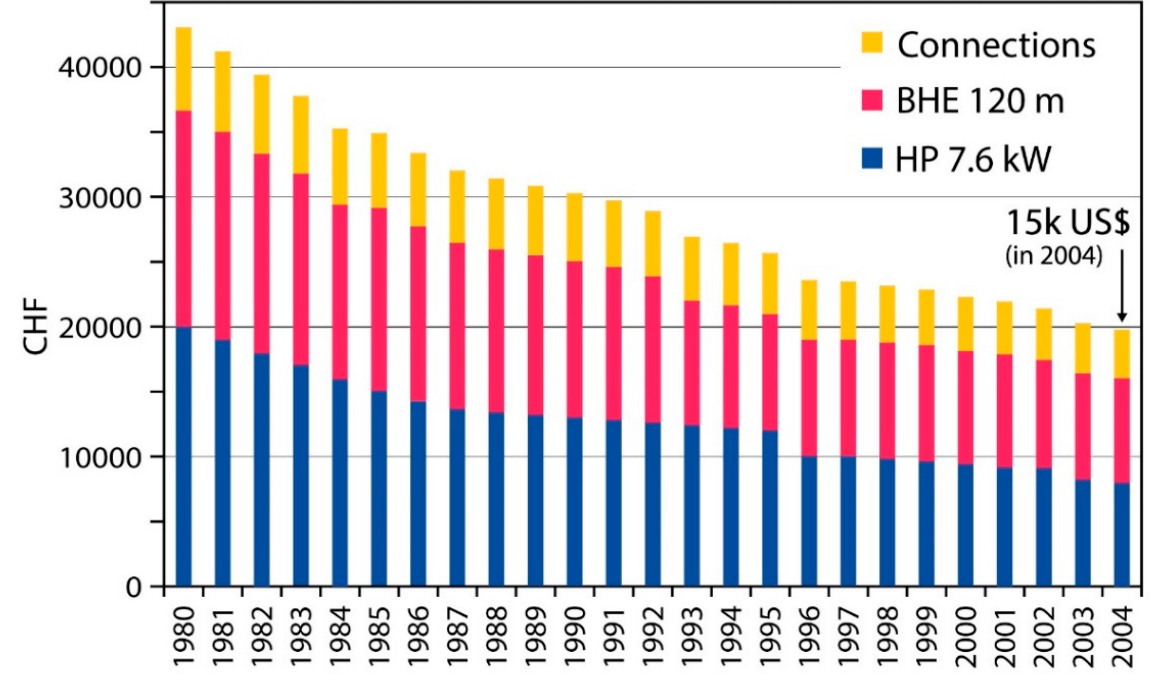
Figure 16. GHP installation cost reduction over the years. From the FWS (Förderverein Wärmepumpen Schweiz) statistics website https://www.fws.ch/statistiken/ (accessed on 5 October 2005). For details, see text.